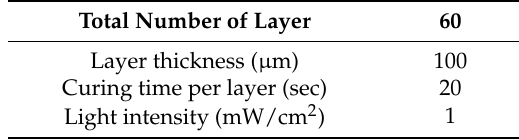
Table 1. Mask projection stereolithography process parameters.